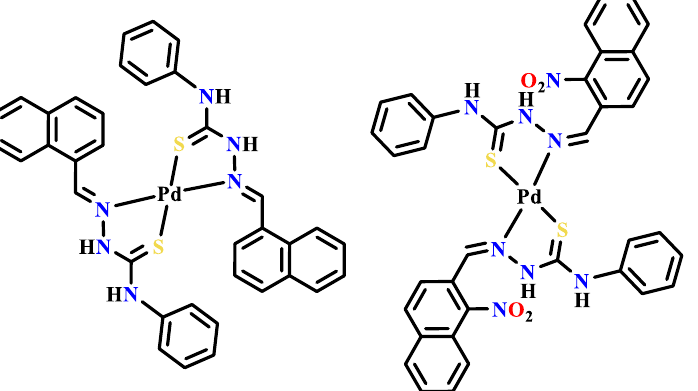
Figure 28. Two symmetric palladium(II) complexes of 1-naphthylhydrazone and 1-nitro-2-naph- thylhydrazone, both with phenylthiourea as a side chain. naphthylhydrazone, both with phenylthiourea as a side